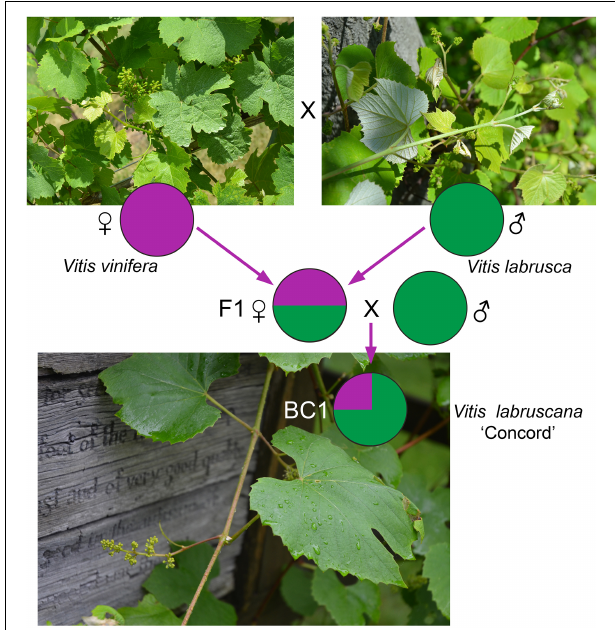
FIGURE 4 | A model for the Concord grape origin based on chloroplast and nuclear DNA evidence. BC1 represents the backcrossed progeny of the F1 hybrid toward one of the parental species, Vitis labrusca